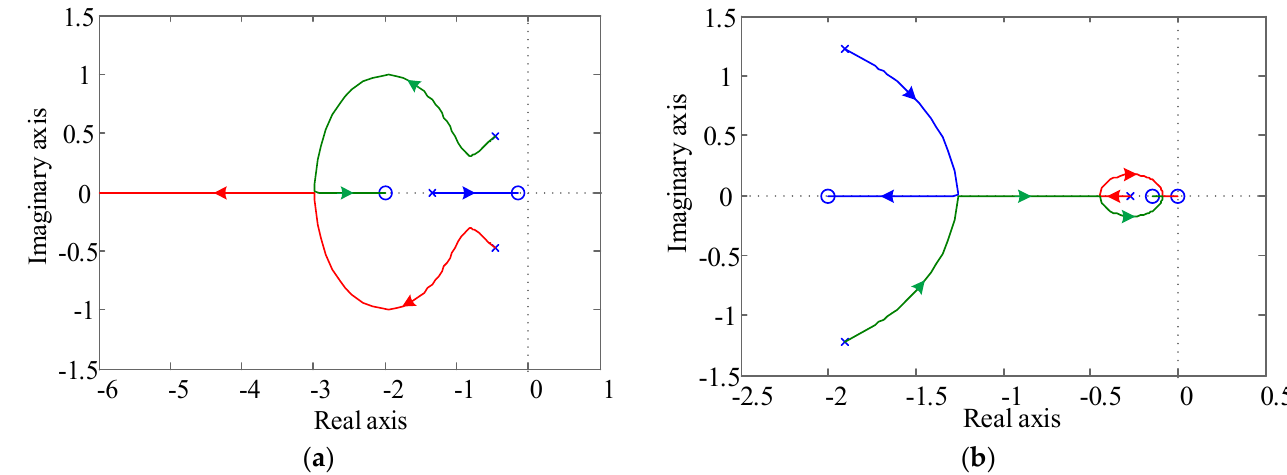
Figure 8. System root locus. ( a ) k p / S B1 as the variable ( H vir = 3.5 s); ( b ) k d / S B1 as the variable ( R vir =